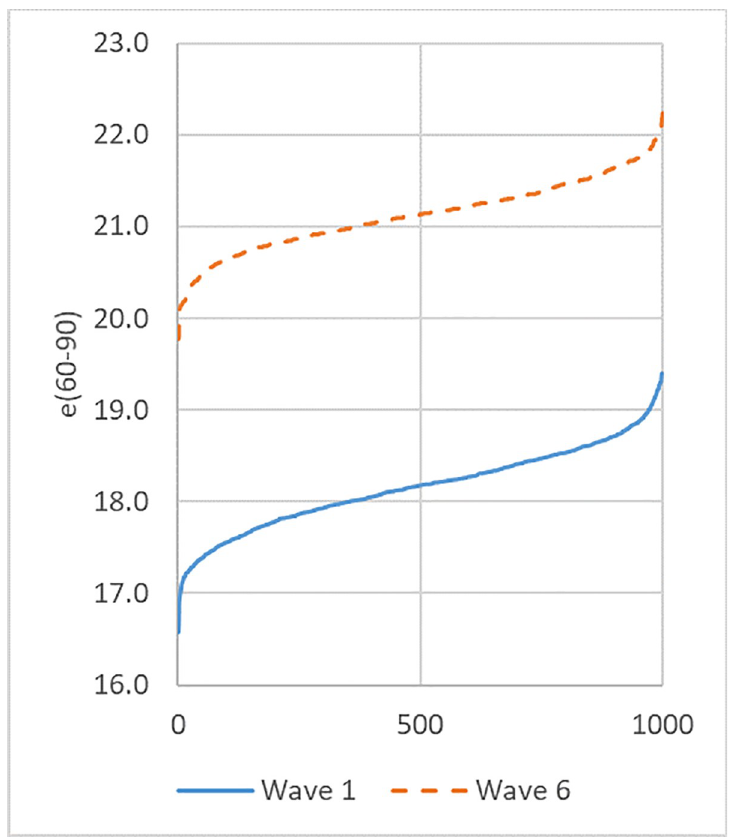
Fig 2. Subjective LE: 1000 values estimated with data from Wave 1 and 1000 values estimated with data from Wave 6 (exact procedure of estimation described in the previous section). Values for each wave are ordered from low to high.